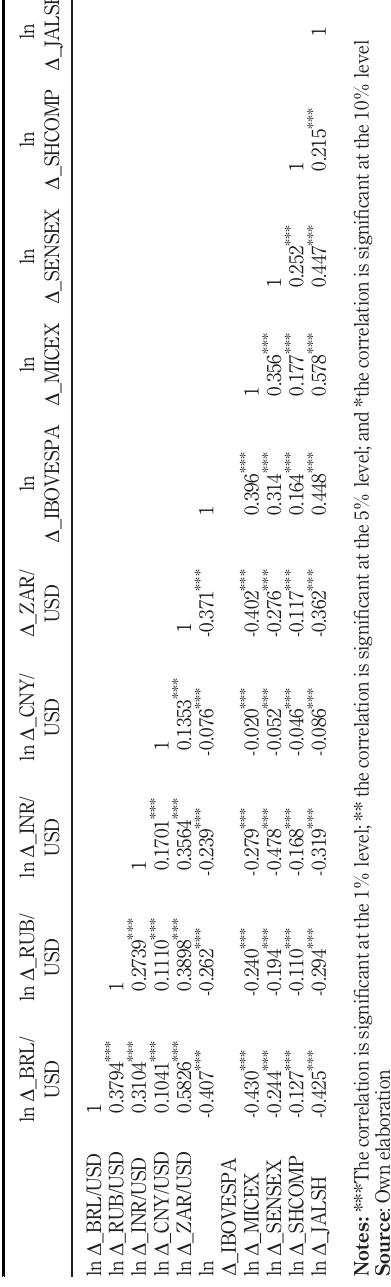
Table II. Correlation matrix between stock market indices returns and exchange rates variations of BRICS countries over the total sample period (January